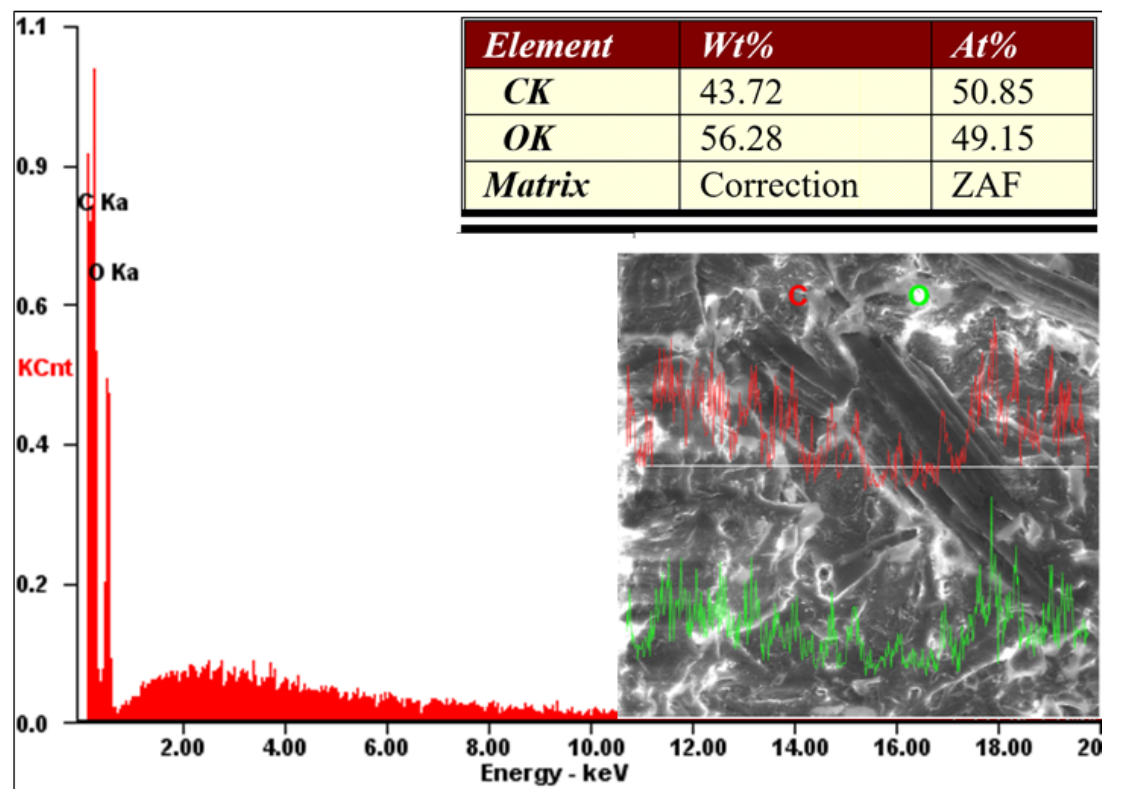
Figure 15. SEM images at different magnification powers for Arboform ® LV3 Nature Nature rein- forced with aramid fibers.